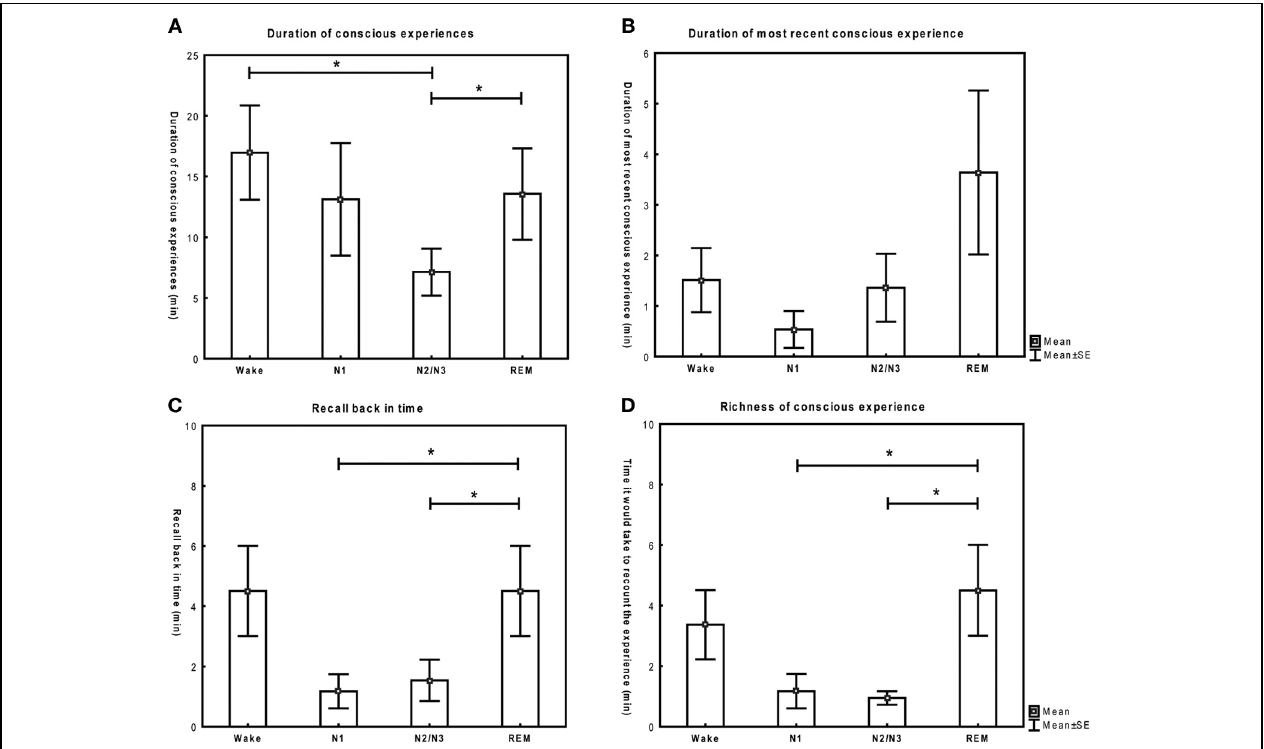
FIGURE 7 | (A–D) Quantitative features of conscious experiences across stages (mean and standard error). Paired t -tests. ∗ p < 0 . 05. Wake: 6 subjects, N1: 5 subjects, N2/N3: 7 subjects, REM: 7